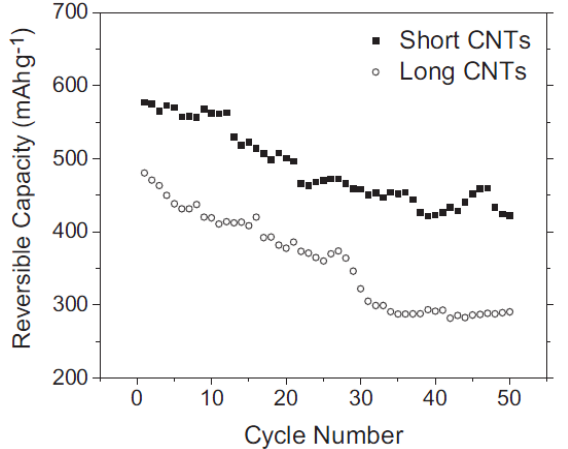
Figure 7. Variation of C with number of cycles at a current density of 25 mAg –1 . Note rev that the capacity becomes stable after 30 cycles. (Reprinted with permission from [66]. Copyright (2007) by Wiley).